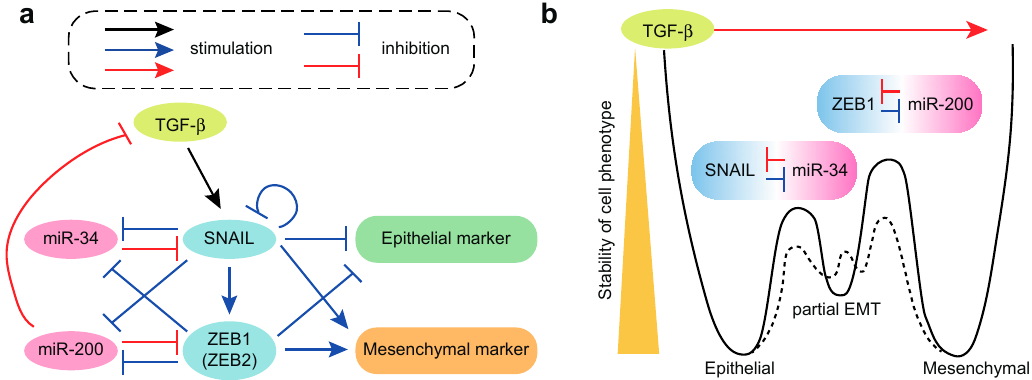
Figure 2. Roles of miRNAs in TGF- β -induced epithelial–mesenchymal transition (EMT). ( a ) EMT circuits containing a SNAIL-miR-34 loop and ZEB1-miR-200 loop; ( b ) A relationship between two miRNA-transcription factor (TF) modules and three EMT states. Solid line indicates the cell state transitions among epithelial, partial EMT and mesenchymal phenotypes, which are controlled by two miRNA-TF molecular switches. Dotted line suggests the alternative transition states generated by additional molecular switches.